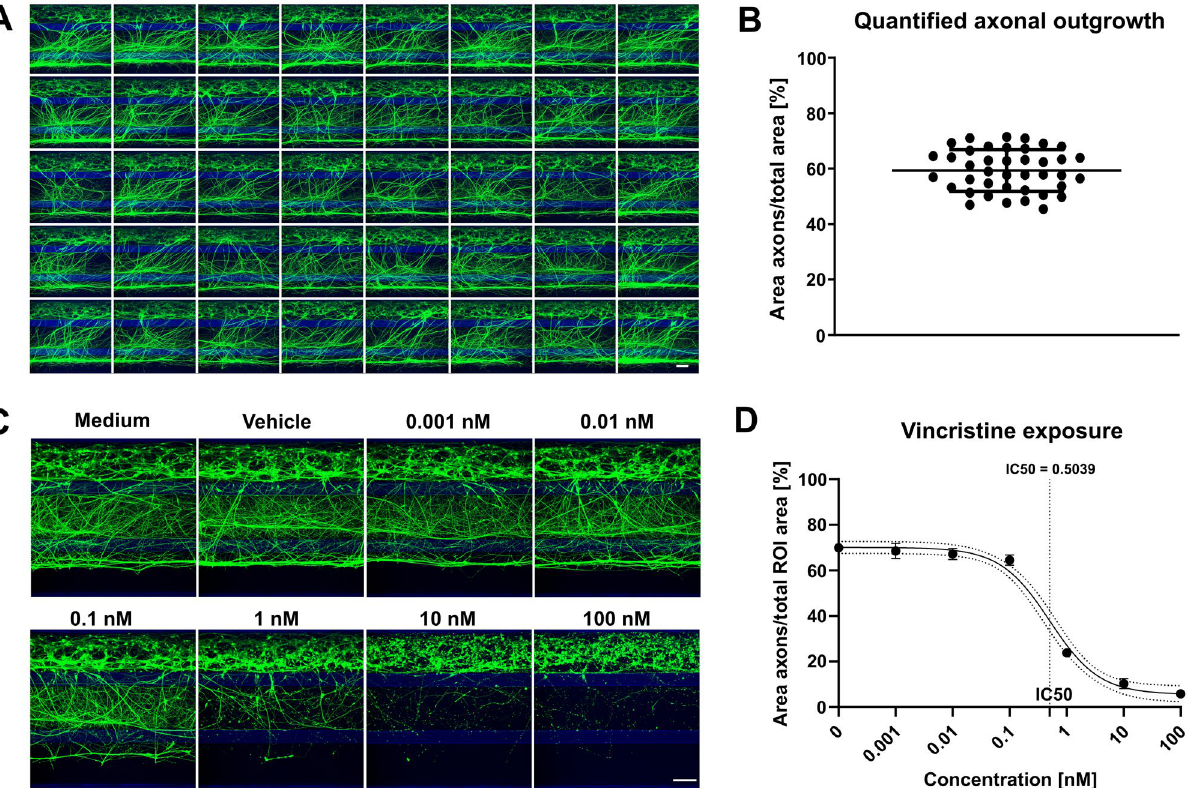
Figure 4. Robust 3D axonal outgrowth model allows assessment of neurite disrupting compounds. ( A ) Montage of a complete OrganoPlate containing 40 chips, each showing 3D axonal outgrowth at day 17 of culture visualized by calcein-AM dye. Maximum projection images, the scale bar is 200 µm. ( B ) Quantification of axonal outgrowth shown in (A), n = 40. Graph shows mean ± SD. ( C ) Motor neurons (day 17) were exposed to various concentrations of vincristine for 4 days. Cultures were visualized with calcein-AM dye. Maximum projection images, the scale bar is 200 µm. ( D ) Quantification of axonal outgrowth depicted in ( C ). Dose–response curve showing the effect of vincristine exposure on axonal outgrowth. Graph shows mean values ± SEM and a 95% confidence interval (dotted lines) around the curve. n = 5. The graphic representations in ( B ) and ( D ) were created using GraphPad Prism, version 8.3.1 (https ://www.graph pad.com/scien tific -softw are/prism